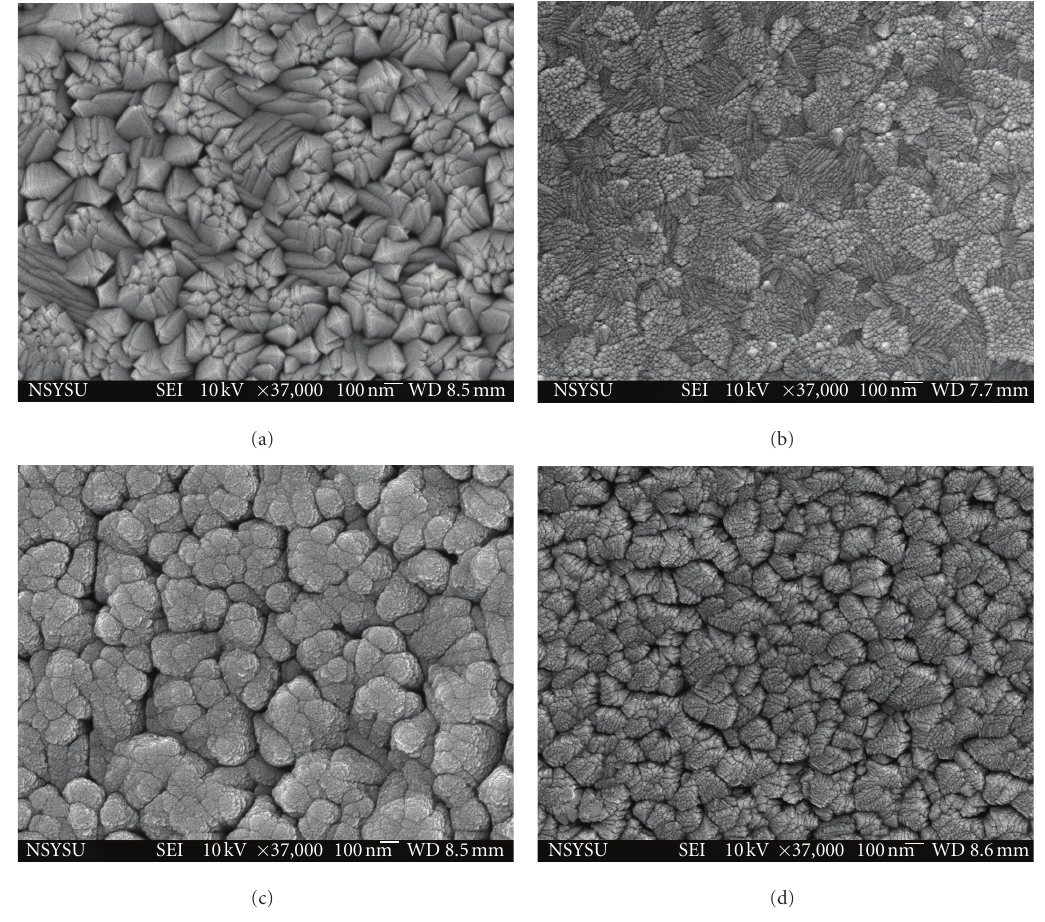
Figure 3: Plain view of SEM images of: (a) N,C-ITO, (b) ITO, (c) Ti/TO, and (d) N,C-TiO 2